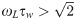
A resonance frequency emerges in the voltage response in one of two ways depending on the intrinsic timescale.For slow intrinsic current (ωLτw>2), a response exhibiting a maximum at ω
max already exists at Ω = 0. For fast intrinsic current (ωLτw<2), a resonance emerges at finite Ω, whose value converges for vanishing ω
Lτw.